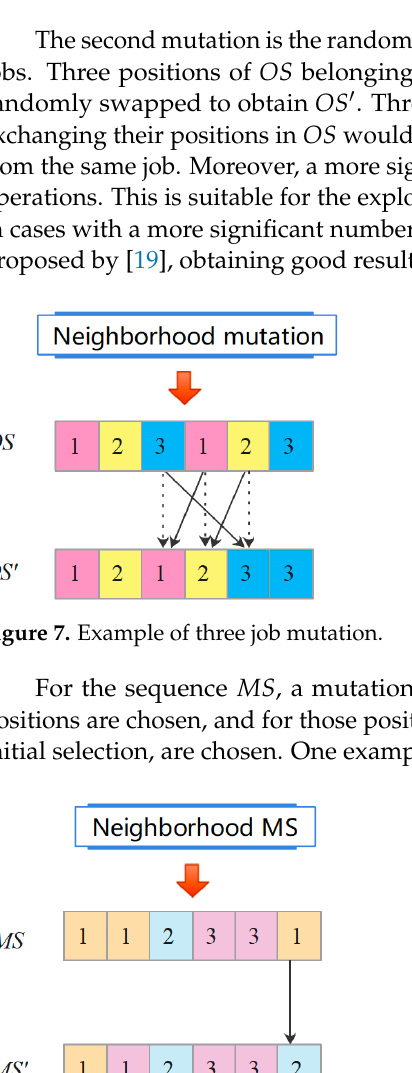
Figure 6. Example of swapping mutation.